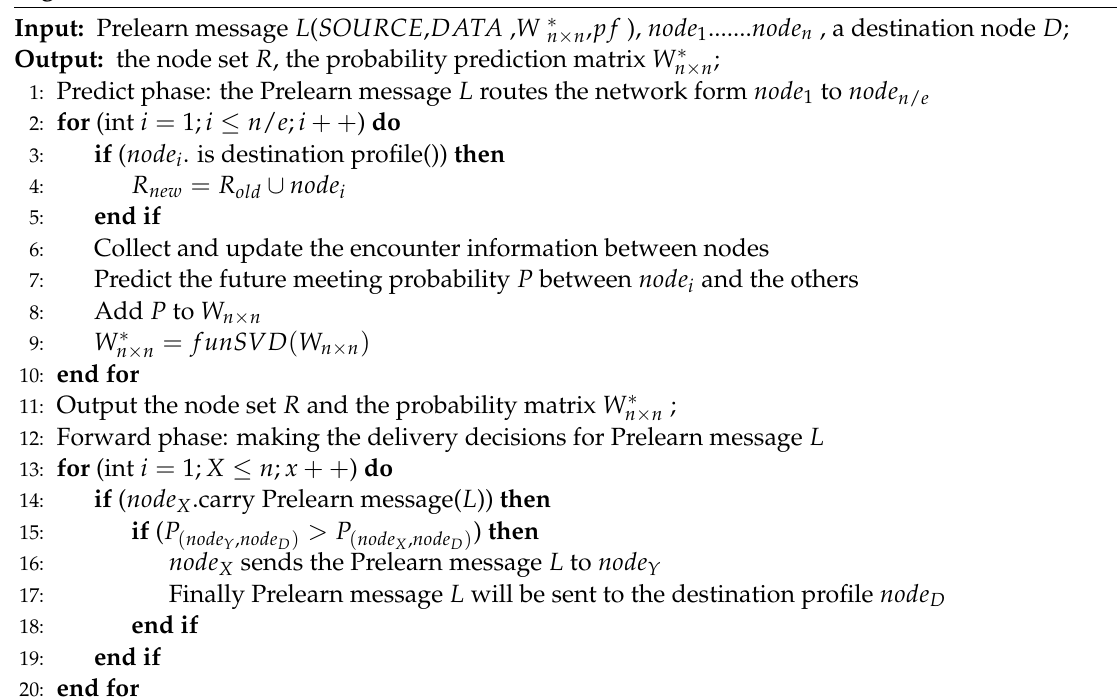
Algorithm 1 Predict and Forward